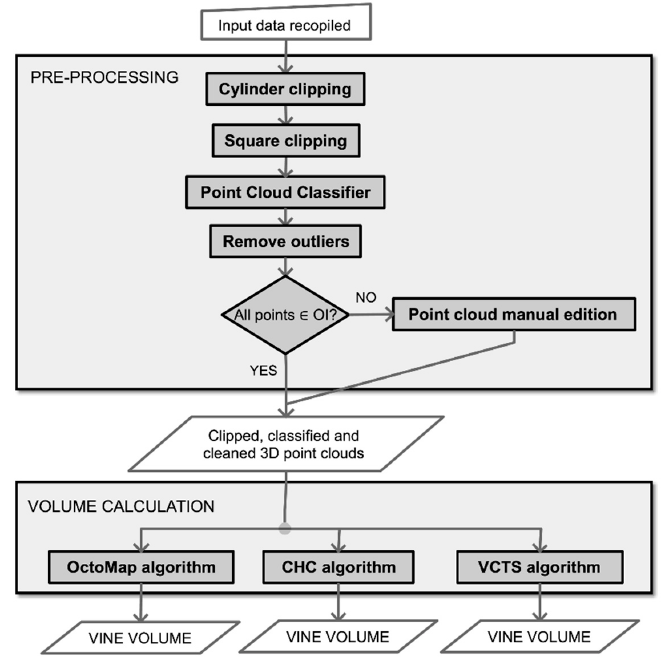
Figure 7. Software flowchart. OI: object of interest. CHC: convex hull cluster. VCTS: volume calculation from the trunk skeleton.